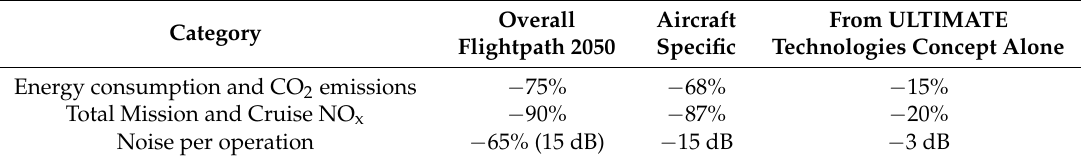
Table 1. Flightpath 2050 goals and target contributions of ULTIMATE